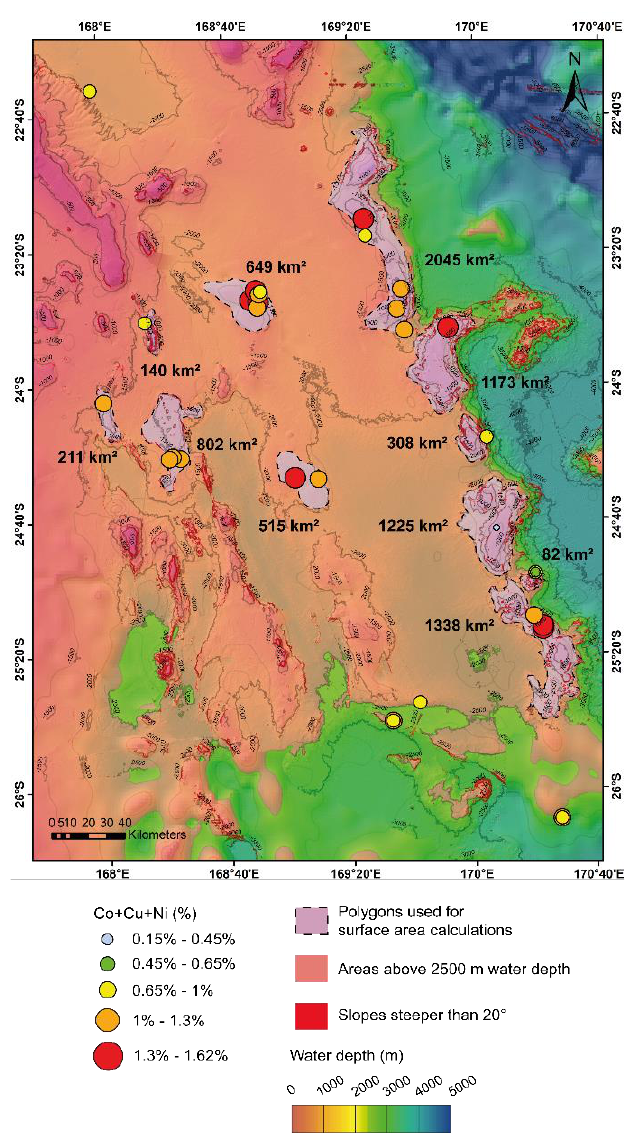
Figure 12. Map of hydrogenetic sample’s Co + Cu + Ni (%) concentration, focused on the Southern part of New Caledonia EEZ, with indications of slope values and surface area (contour lines = 500 m).